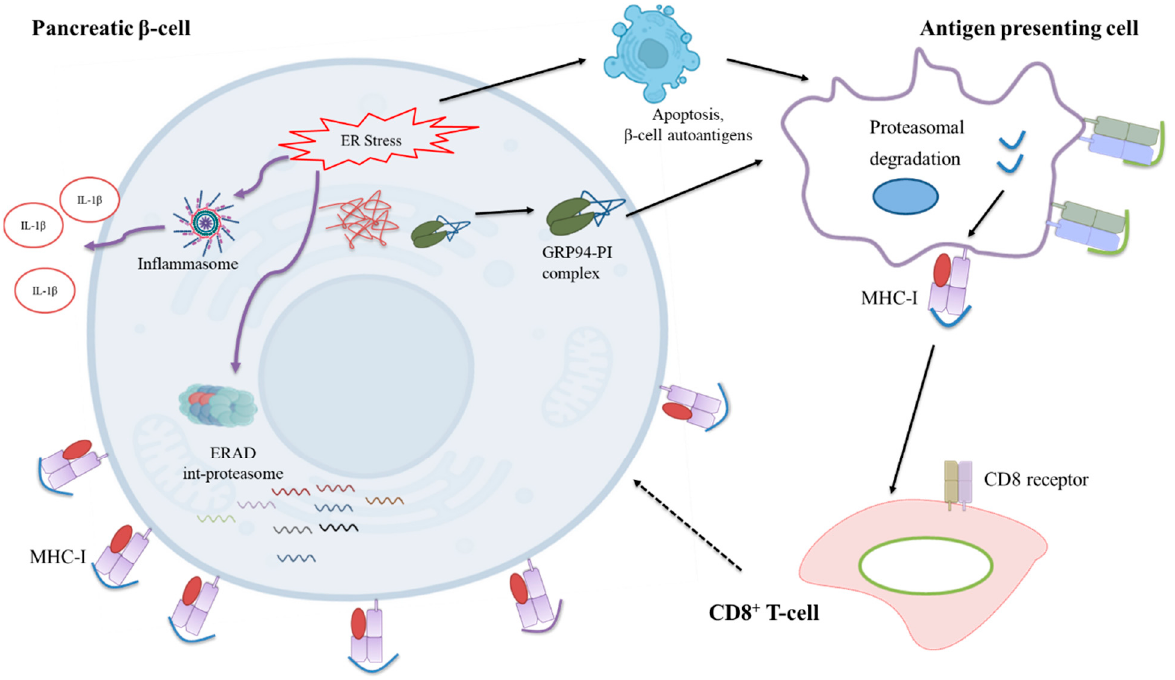
Figure 8. Proposed mechanism of autoimmunity induction in T1D. A defect in the ability of GRP94 to process proinsulin leads to an accumulation of mishandled proinsulin in β -cells. This leads to ER stress, activation of inflammatory pathways, assembly of int-proteasome, and secretion of GRP94-PI complexes. Simultaneously, the increased MHC-I expression on β -cells make them more visible to immune cells. The secreted GRP94-PI complexes are taken up by APCs and cross-presented to CD8 + T-cells to trigger immune attack against β -cells.